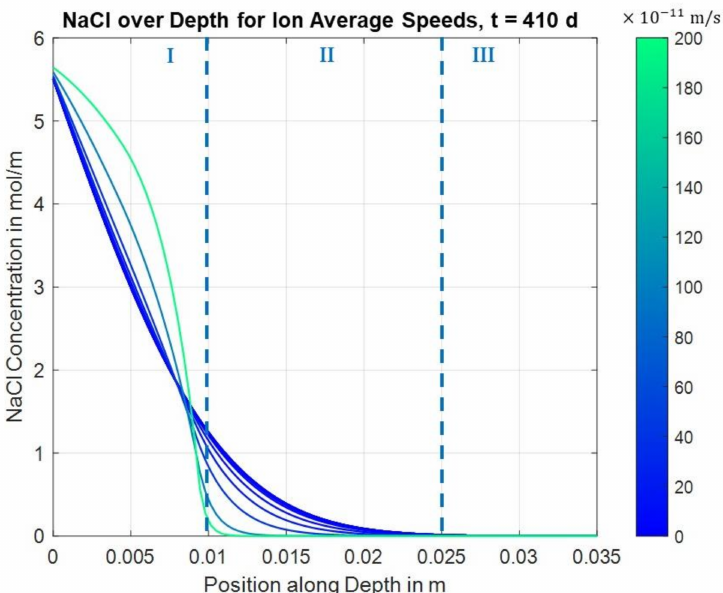
Figure 6. Finite differences solutions for concentration over position for different migration velocities (t = 410